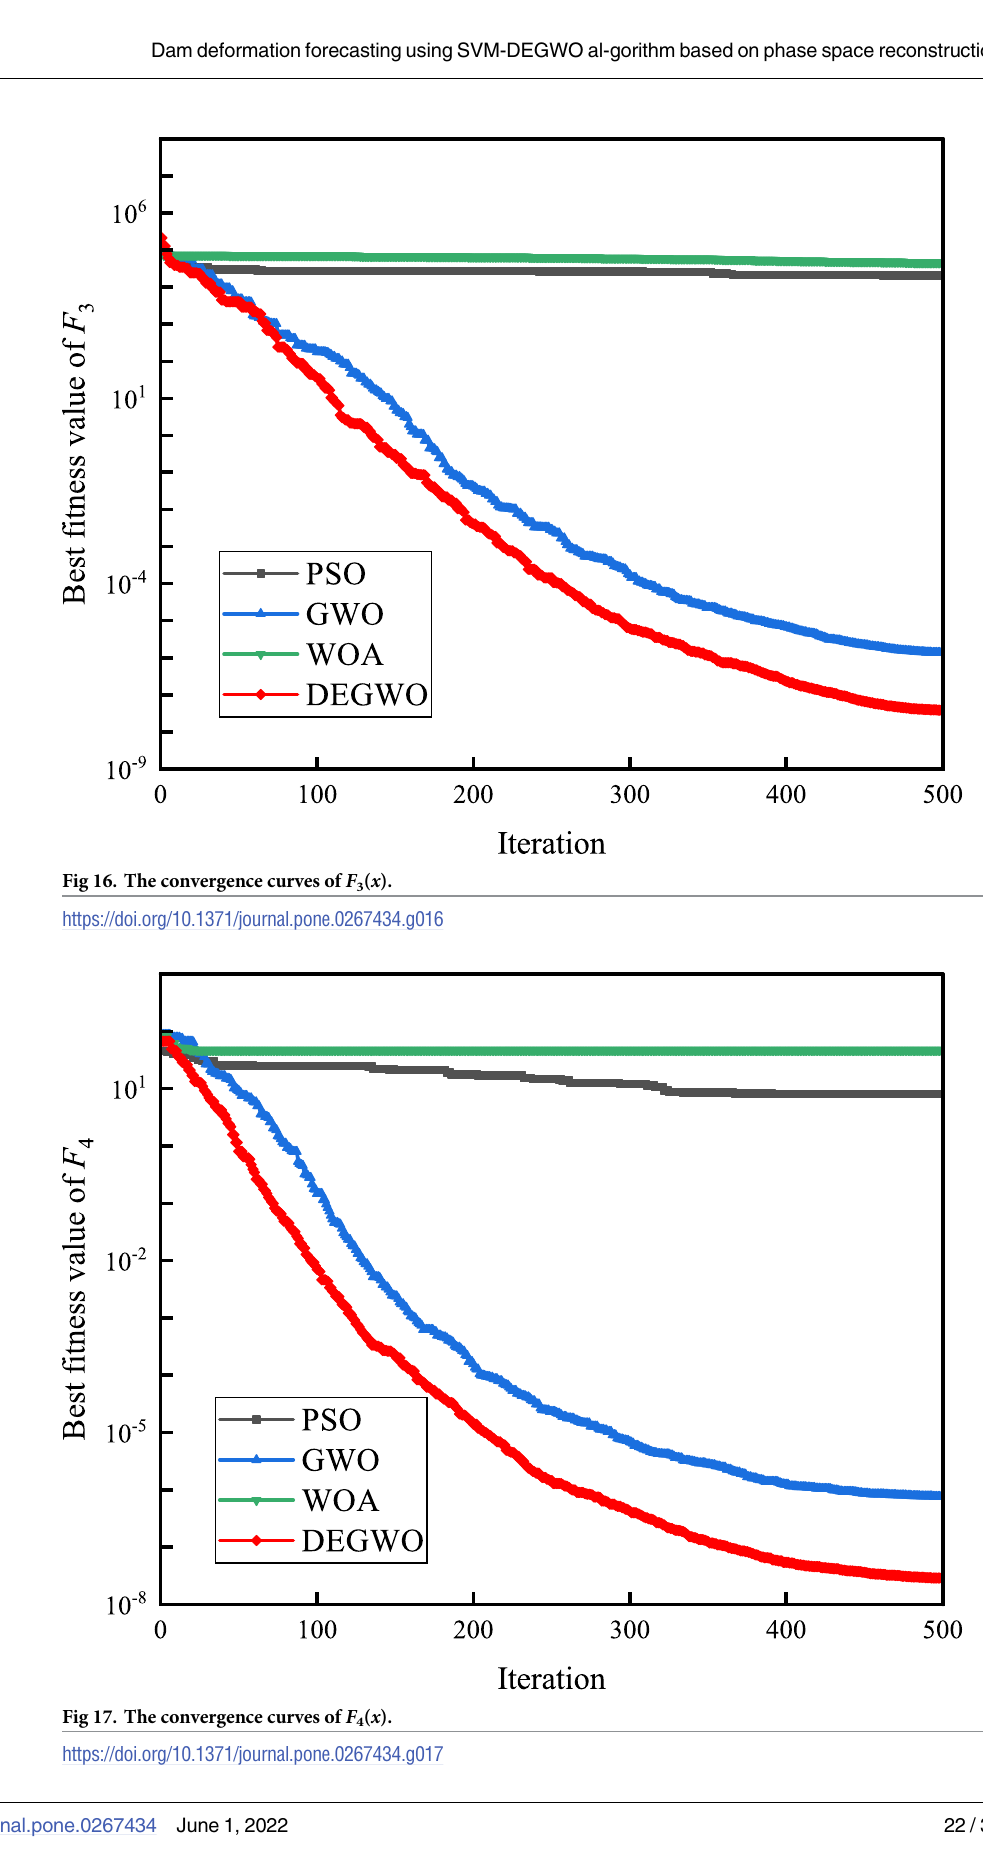
Fig 17. The convergence curves of F 4 ( x ).